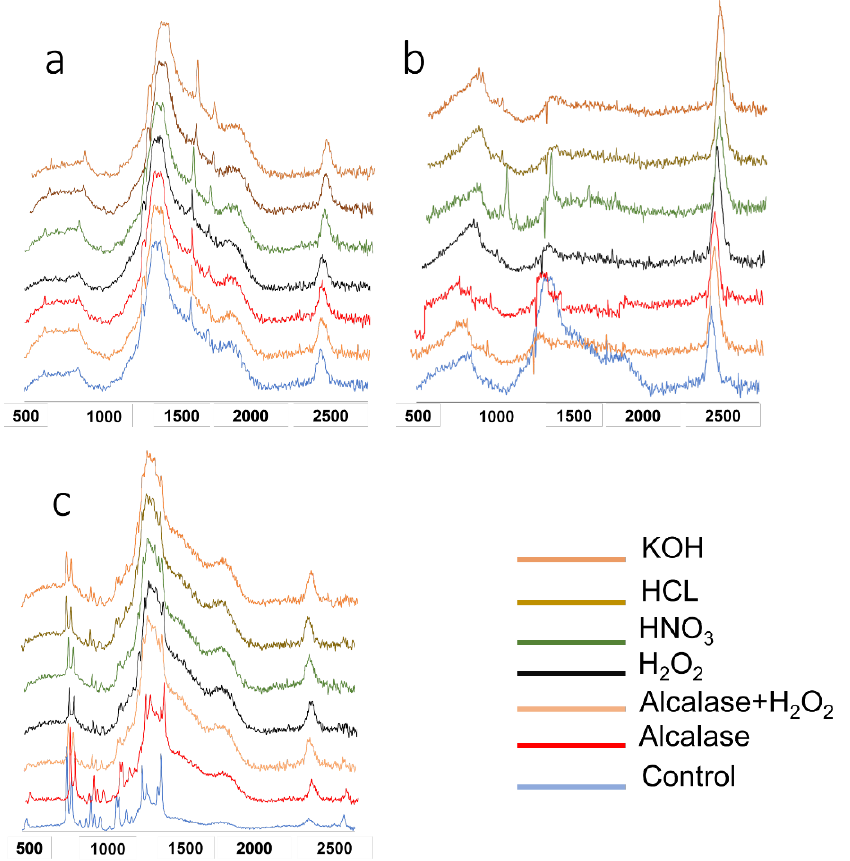
Figure 2. Raman spectra of ( a ) PET, ( b ) PS, and ( c ) PP exposed to different chemicals .